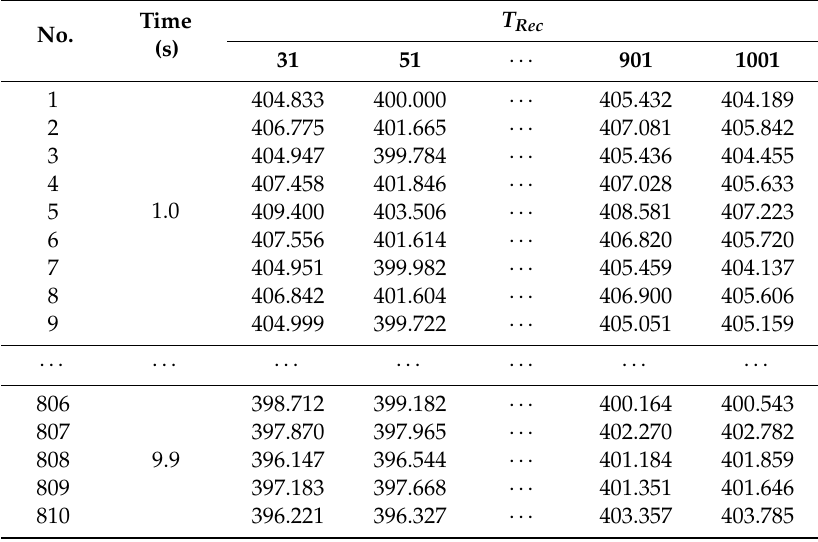
Table 1. T Rec per 18 candidate cycles used in [Step